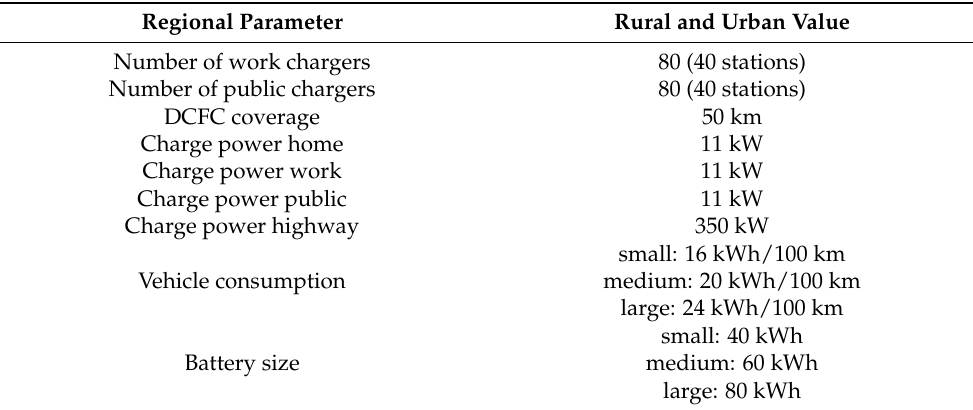
Table 2. Reference case parametrization.